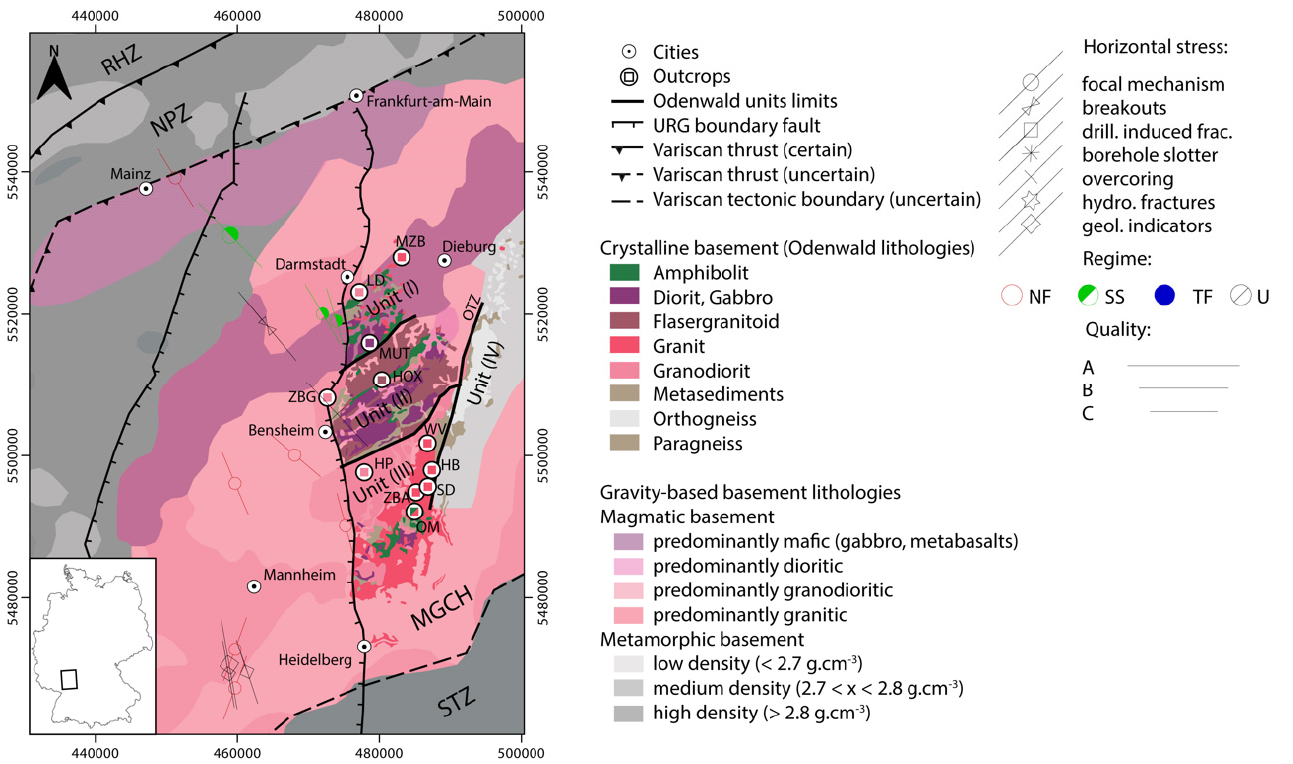
Figure 1. Geological map adapted from [79] for crystalline basement lithologies from the Odenwald, and [3] for lithological and tectonic boundaries based on the interpretation of the joint inversion of gravity and magnetics. Gravity and magnetics boundaries were extracted from [3], copyright Elsevier (2021). Outcrops are marked and colour coded according to their main lithology. Horizontal stresses are from [80]. Domain labelling: RHZ: Rheno-Hercynian Zone, NPZ: Northern Phyllite Zone, MGCH: Mid-German Crystalline High, STZ: Saxo-thuringian Zone, OTZ: Otzberg Fault sys-